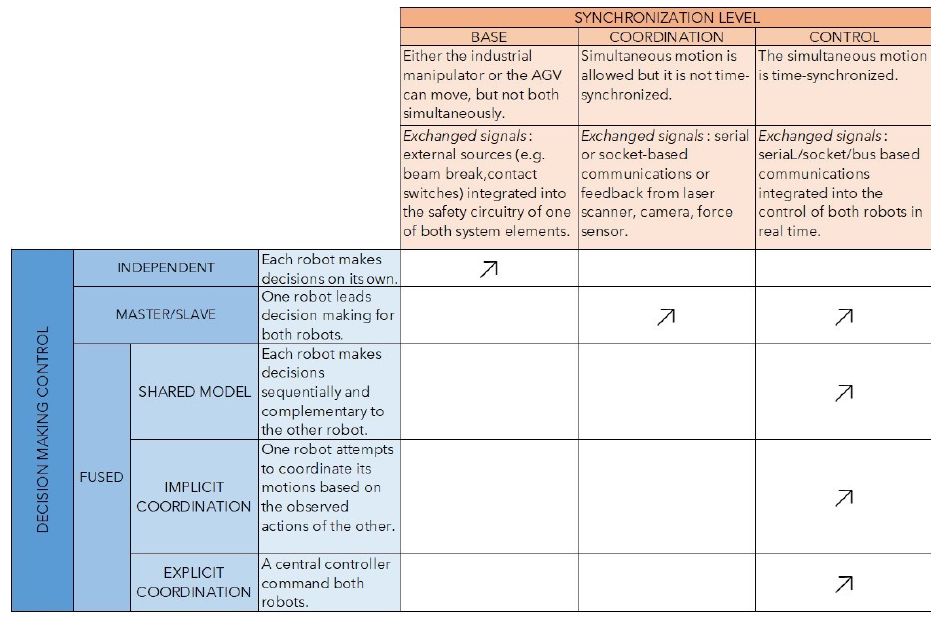
Figure 5. Methods for decision-making control and levels of synchronization for components of mobile manipulators. Adapted from